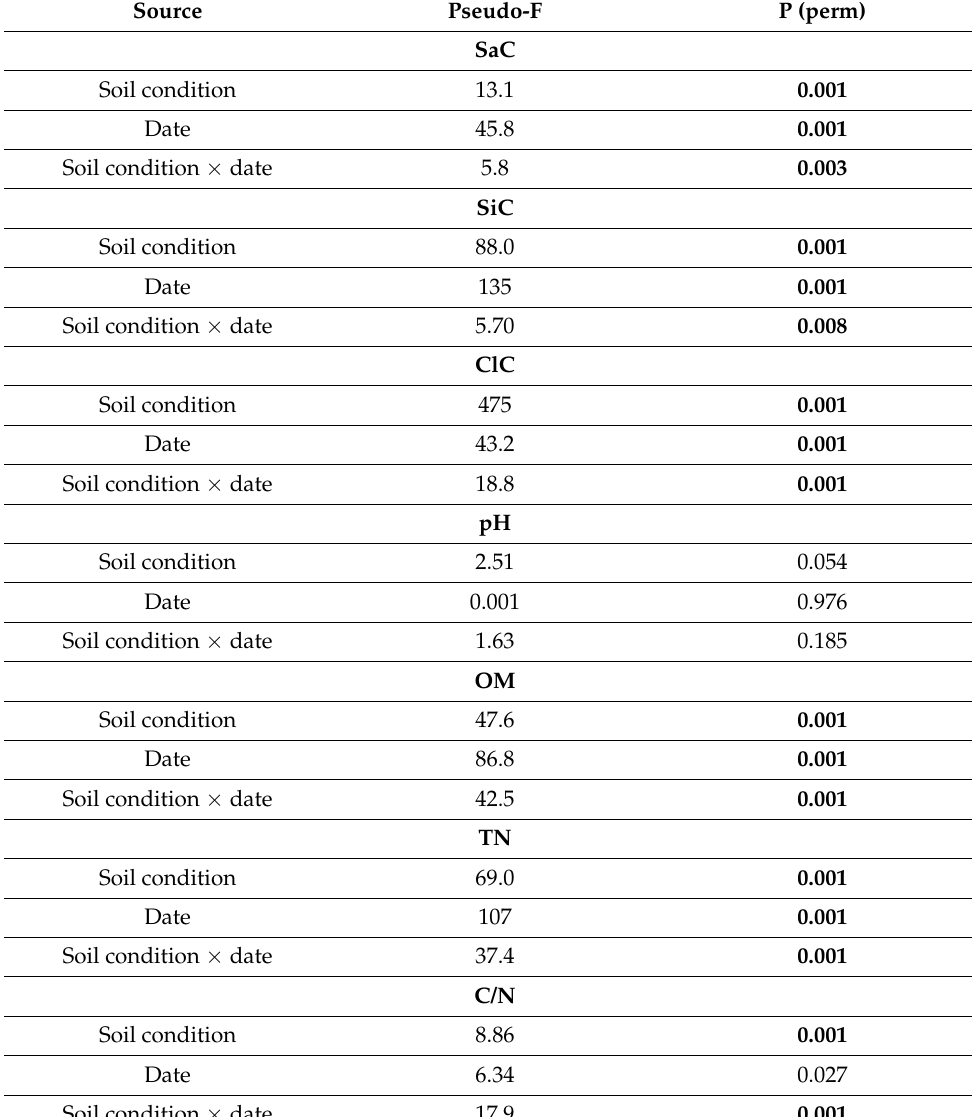
Table 2. Results of the PERMANOVA that was applied to the main soil parameters that were measured at two dates under five soil conditions in the experimental site (Li é tor, Castilla La Mancha,